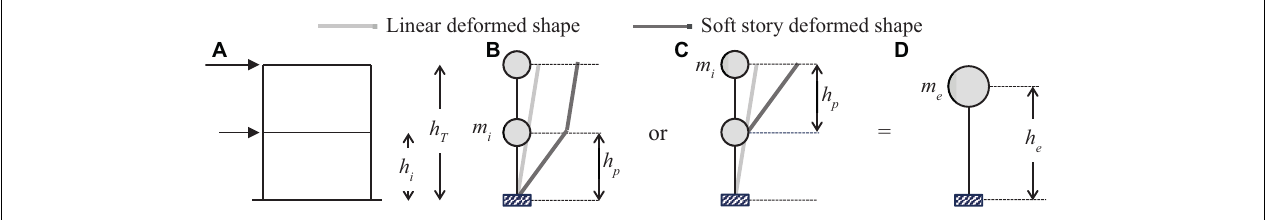
FIGURE 4 | Idealization of (A) MDOF system, (B) soft floor in first level, (C) soft floor in second level, and (D) SDOF system according to SP-BELA method.